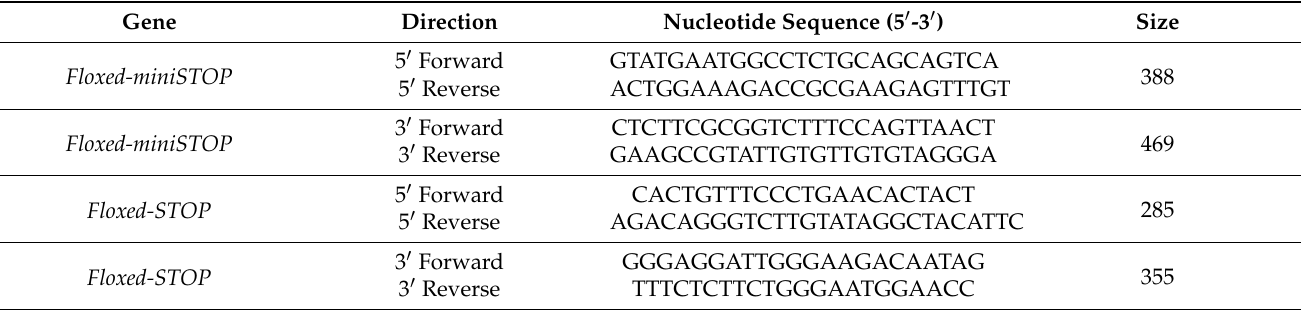
Table 2. Primers for genotype knock-in